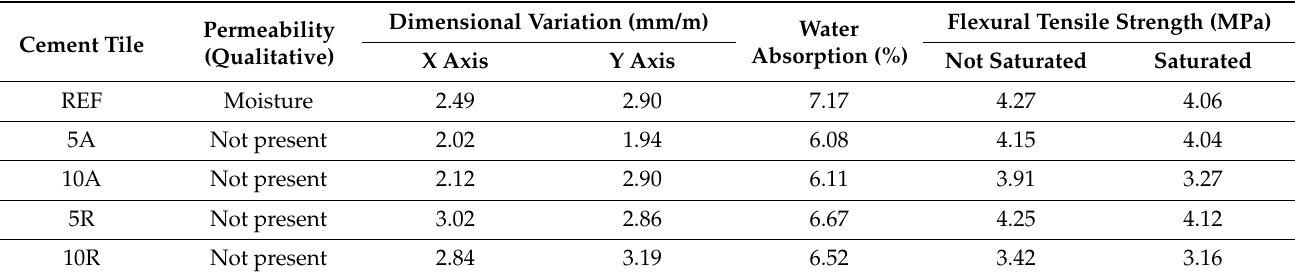
Table 3. Physical properties and flexural strength of cement tiles produced with different contents of anatase and rutile titanium